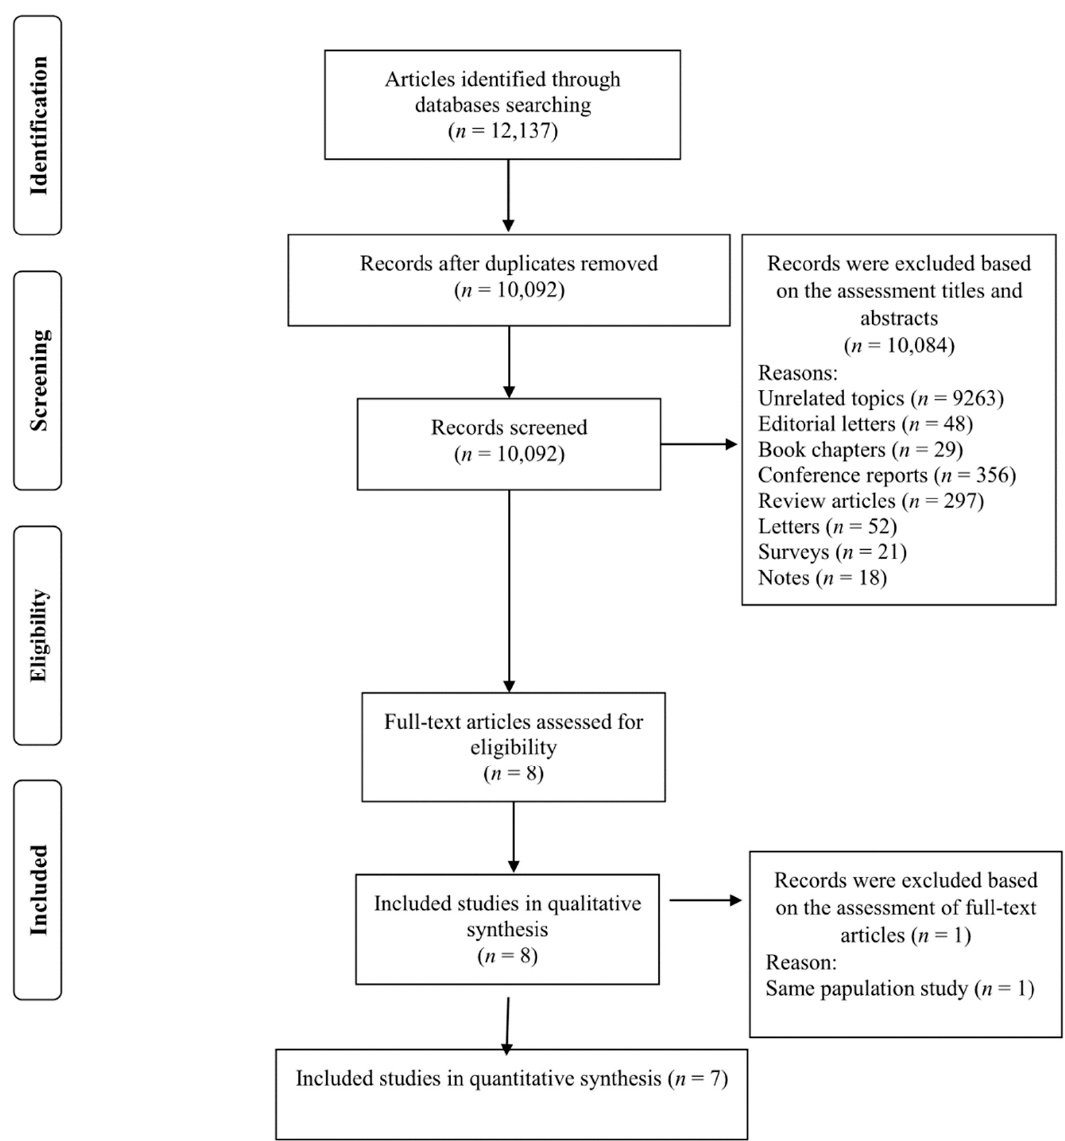
Figure 1. Flowchart of the process of the study selection.